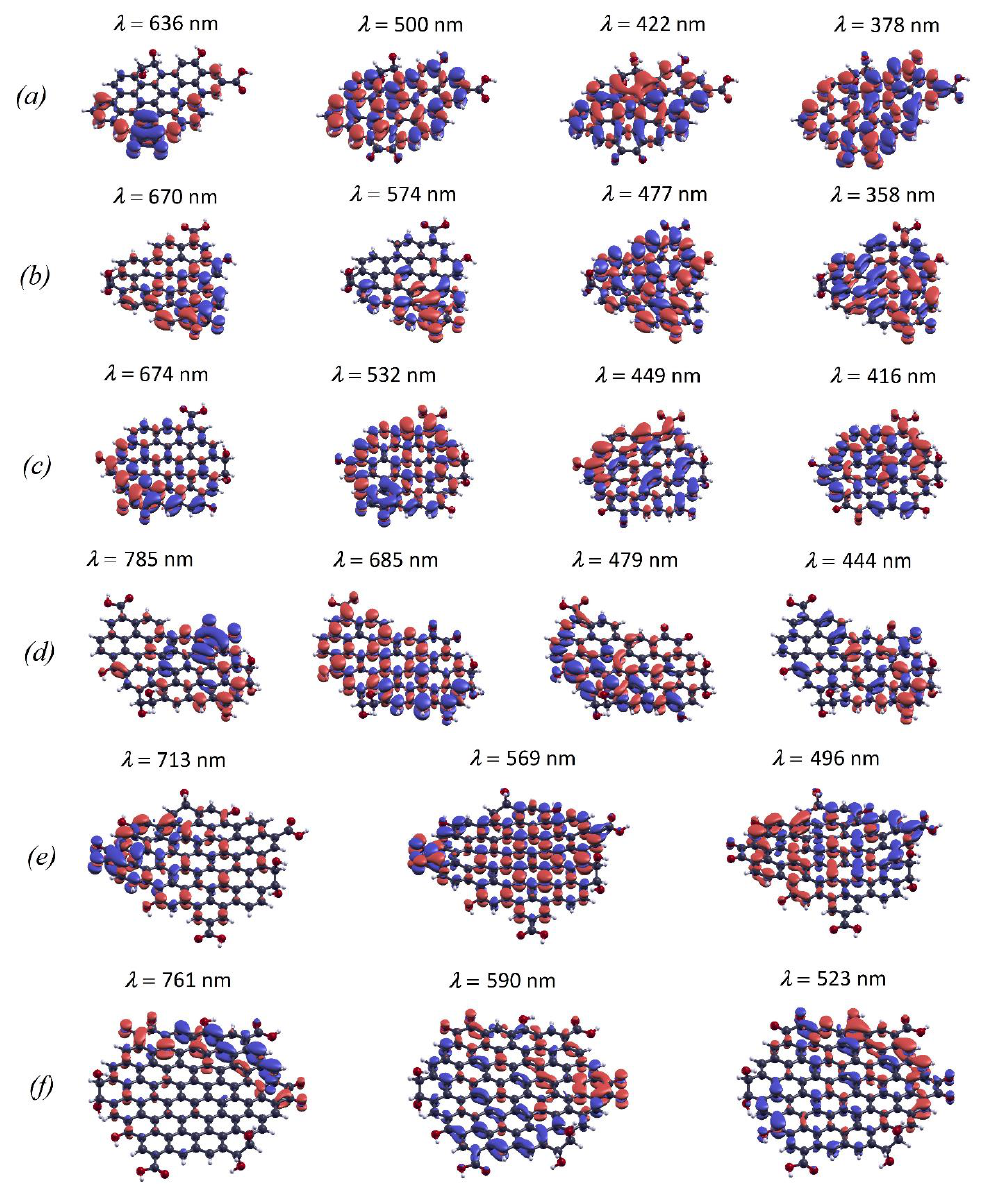
Figure 4. Response charge density to a perturbing electric field of selected wavelength for the